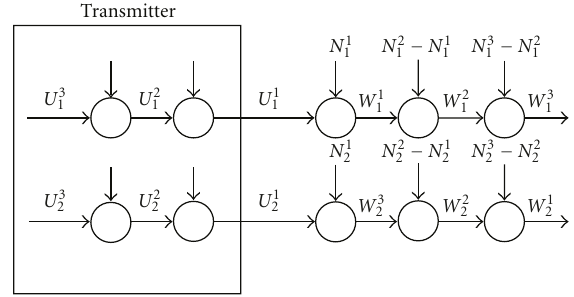
Figure 2: The product of 2 unmatched degraded broadcast channels with 3